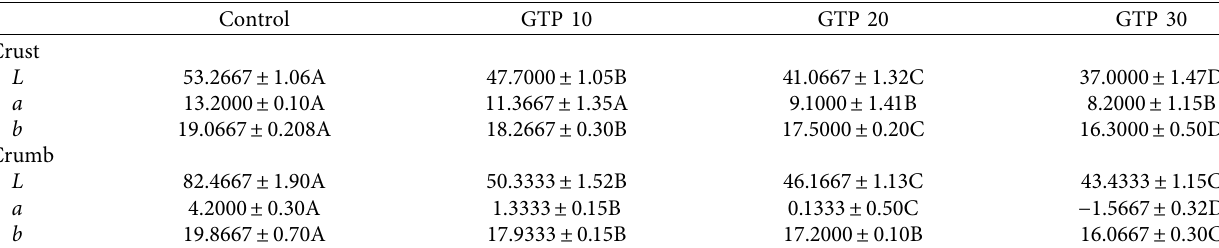
Table 5: Color properties of various sponge cake samples.